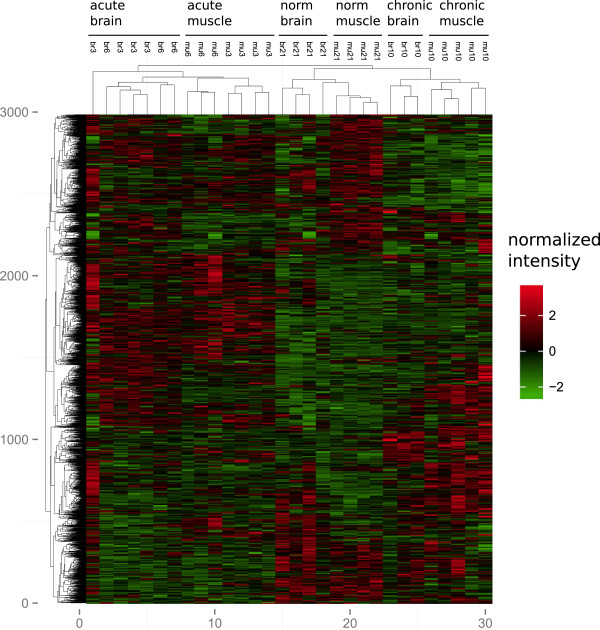
Heat map representation of differentially expressed genes. Based on microarray intensities, we performed hierarchical clustering of hypoxia induced genes and samples. The results indicate sharp differences between acute and chronic responses in Spalax, with clear tissue and treatment specific clades. In addition, it appears that acute hypoxia (3% and 6% O2) elicits similar responses both within and between tissues.